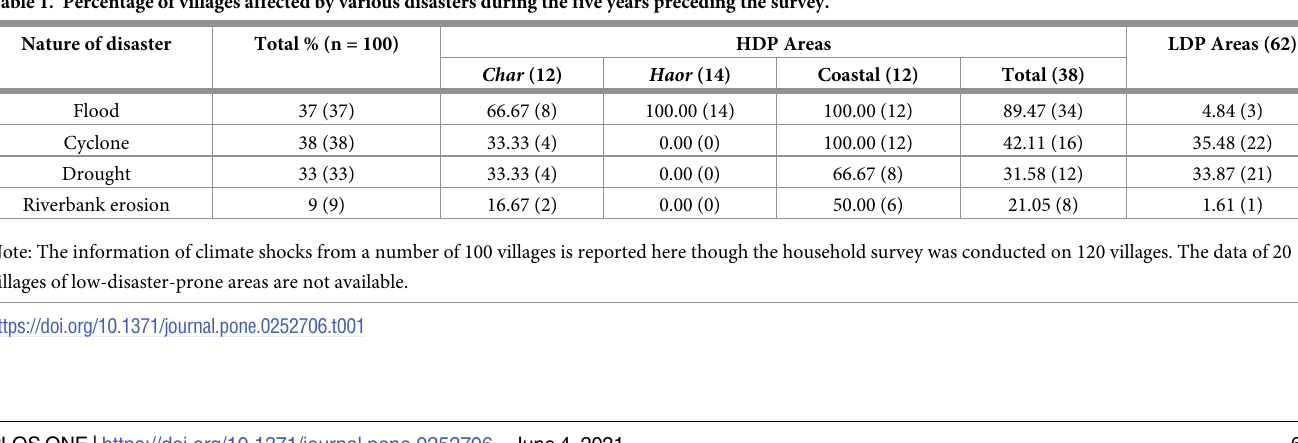
Table 1. Percentage of villages affected by various disasters during the five years preceding the survey. Nature of disaster